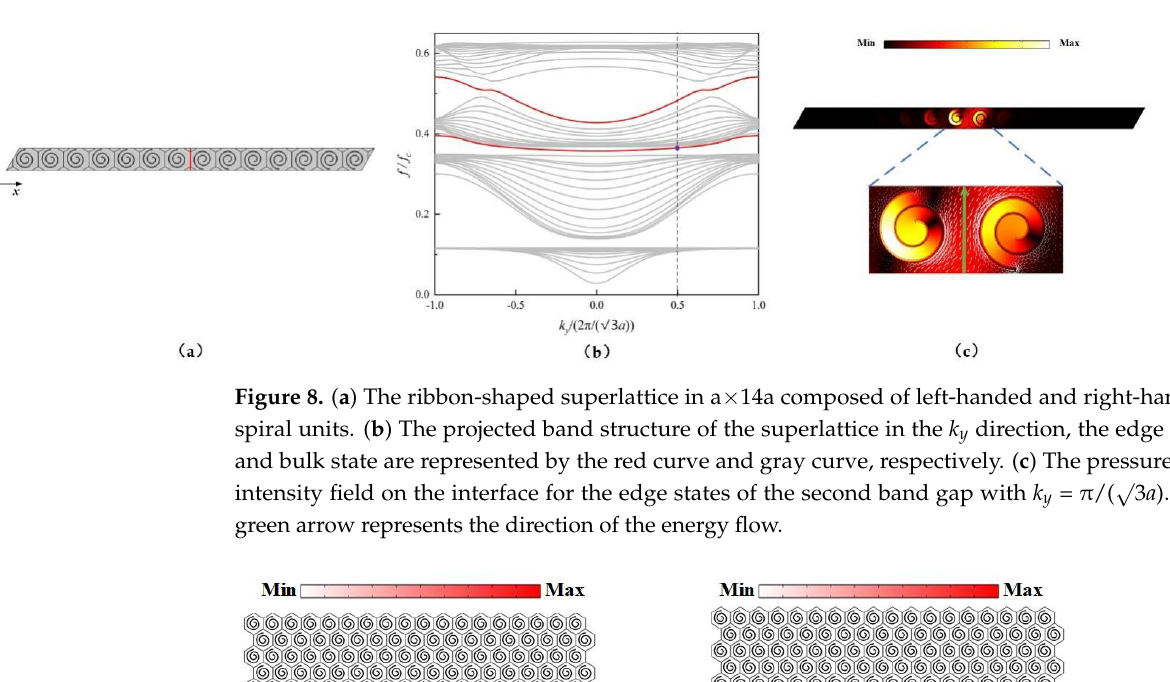
arrow represents the direction of the energy flow.